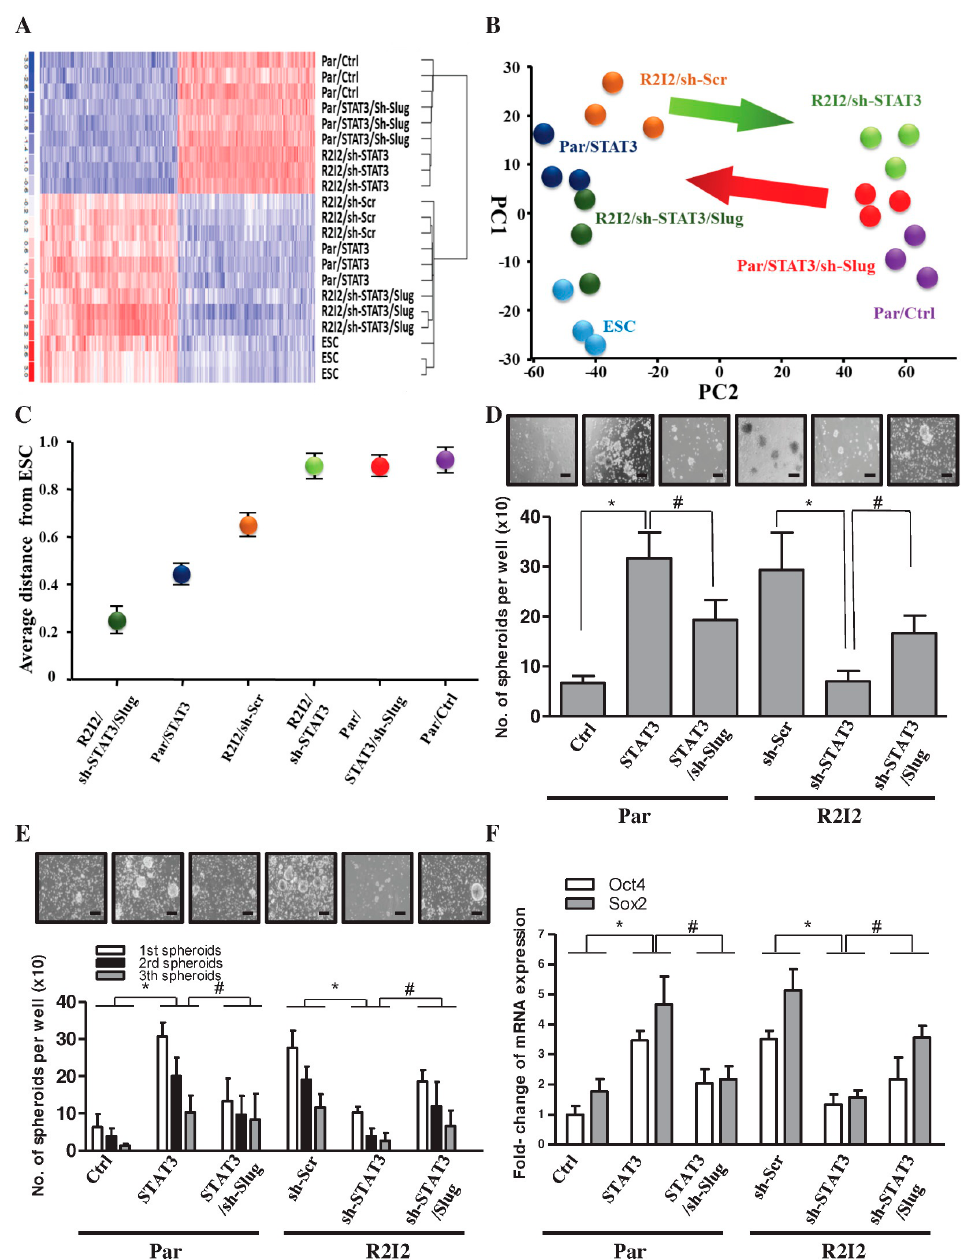
Figure 4. STAT3/Slug signaling mediates stemness properties in GBM-R2I2 cells. ( A ) Gene tree 1 (genetic microarray) showing differentially expressed targets in human embryonic stem cells (ESC), GBM-Par/Ctrl cells, GBM-Par/STAT3 cells, GBM-Par/STAT3/sh-Slug cells, GBM-R2I2/sh-Scr cells, GBM- R2I2/sh-STAT3 cells, and GBM-R2I2/sh-STAT3/Slug cells as indicated by a hierarchical heat map. Blue: low gene expression, Red: high gene expression. ( B ) Principal component analysis (PCA) and ( C ) Multidimensional scaling (MDS) analysis demonstrated the average lineage transcriptome distances between the seven cell lines. ( D ) Sphere formation and ( E ) self-renewal assays were used to analyze sphere-forming rate in the above six cell lines. Scale bars: 50 µ m. ( F ) Q-PCR expression of Sox2 and Oct4 in the above six cell lines. * p < 0.01; # p < 0.01 by Student’s t -test. The data are presented as the mean ± SD of three independent